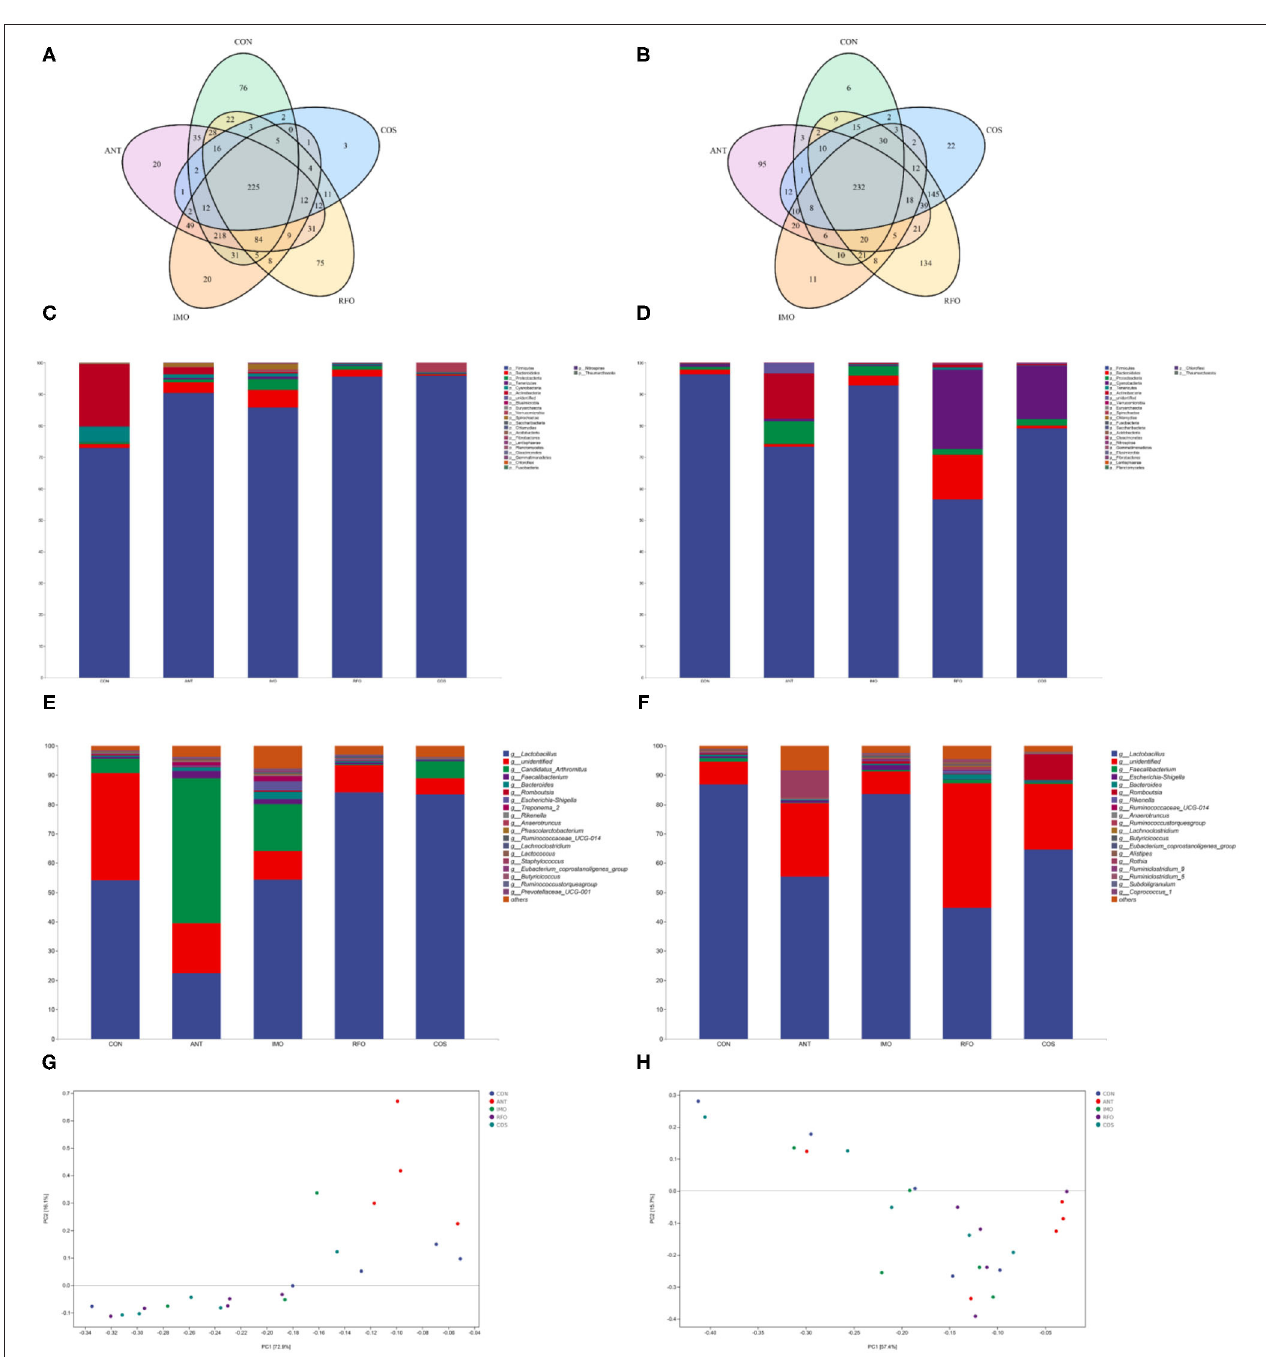
FIGURE 3 | Oligosaccharides alter the composition of the gut microbiota in the broiler ( n = 5). Venn diagrams showing the unique and shared OTUs in the gut microbiota of the groups (A,B) . Community taxonomic composition and abundance distribution map at the phylum level (C,D) . Community taxonomic composition and abundance distribution map at the genus level (E,F) . PCA clustering analysis (G,H) . ANT, IMO, RFO, and COS correspond to supplemented with chlortetracycline, isomalto-oligosaccharide, raffinose oligosaccharide, and chitooligosaccharide in diet, respectively.